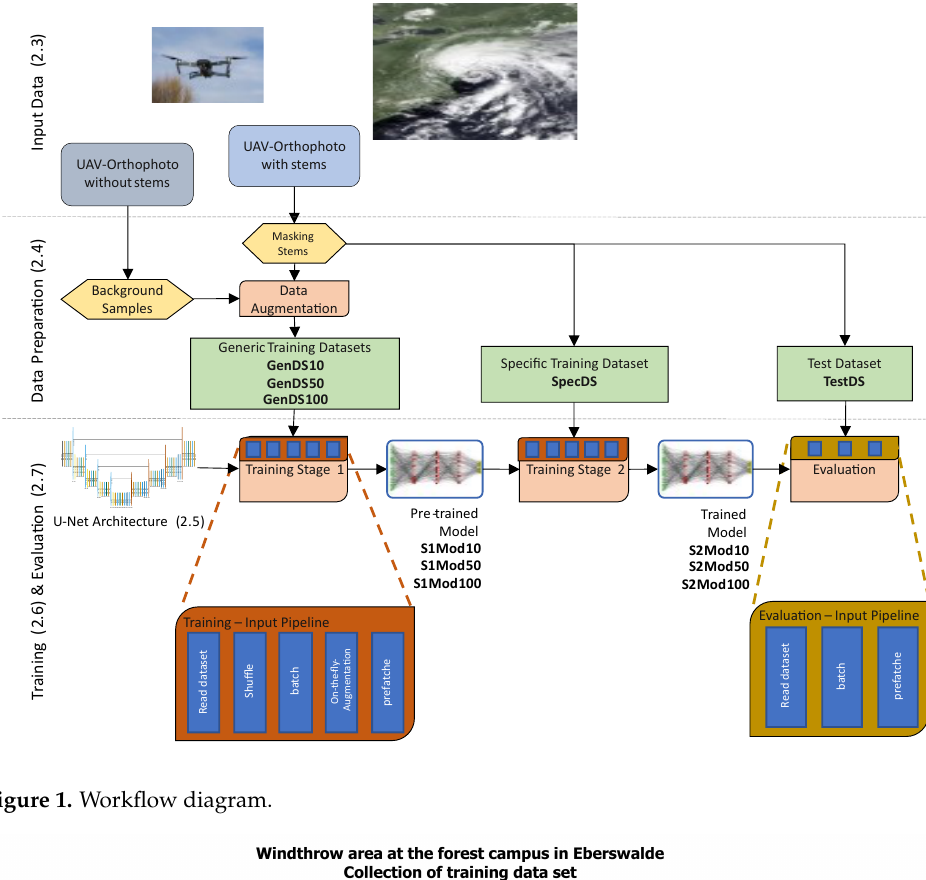
Figure 1. Workflow diagram.